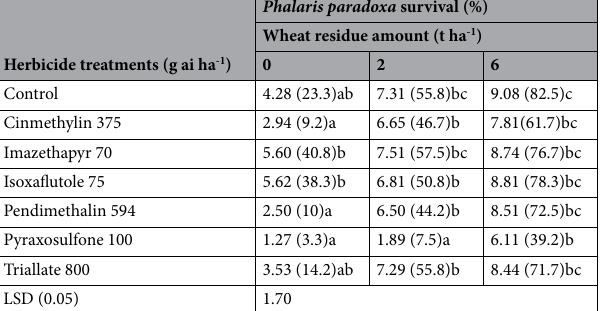
Table 2. The interaction of PRE herbicides and wheat residue amount on the survival of Phalaris paradoxa seedlings at 28 d after spray. The means sharing similar letter(s) are statistically similar. Weed survival data were subjected to square-root transformation before analysis. Original values are shown in